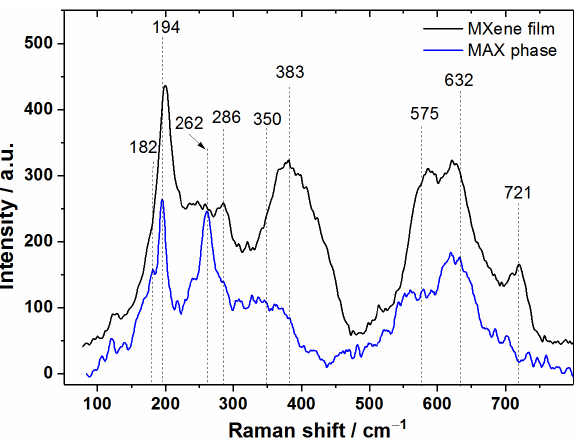
Figure A3. Raman spectra of Ti 3 C 2 T x films and Ti 3 AlC 2 MAX phase excited with a 532 nm laser.